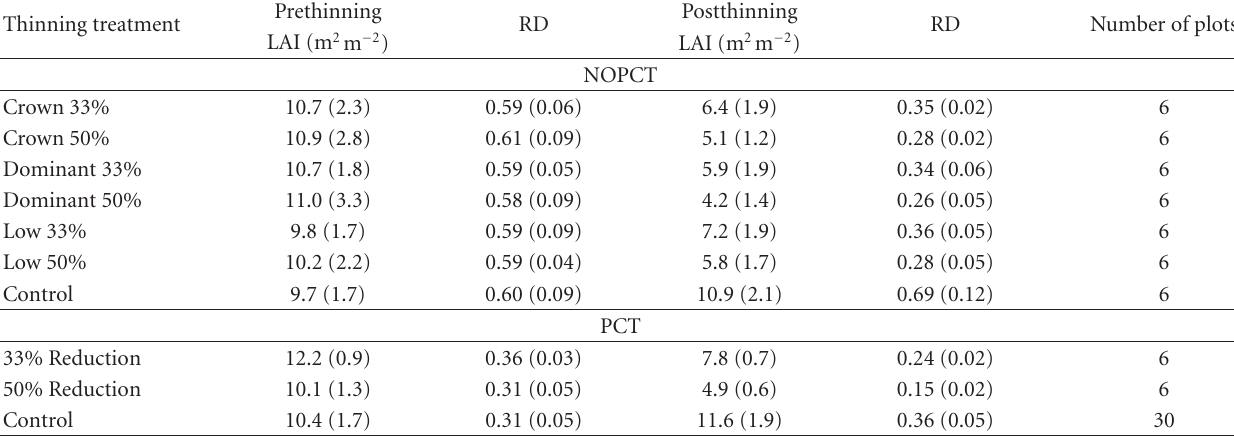
Table 1: Mean (standard deviation) and sample size by treatment type and thinning history for pre- and postthinning leaf area index (LAI) and relative density a